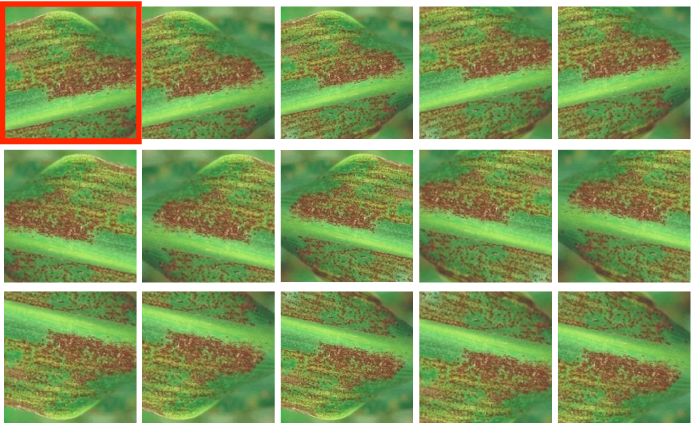
Figure 5. All amplified images corresponding to a single image. First, the image in the red box in the upper left corner is the original image cropped based on the center point. Then the rest four images in the first row are cropped based on the original image’s top left, top right, bottom left, and bottom right. Additionally, images in the second row are horizontally flipped images in the first row. Images in the third row are vertically flipped images in the first